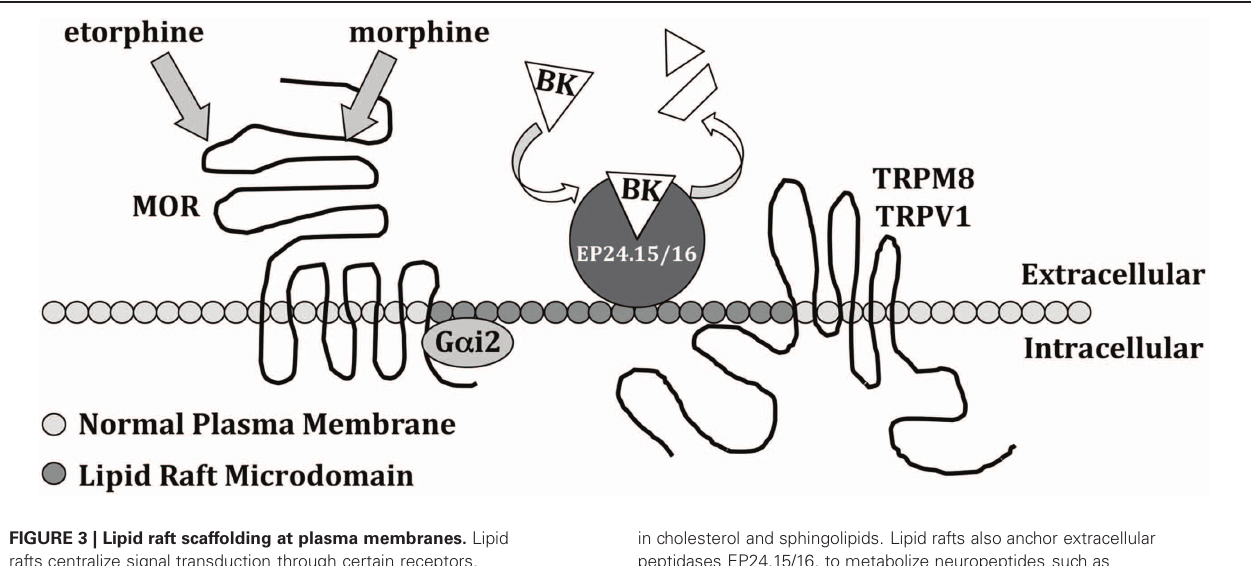
FIGURE 3 | Lipid raft scaffolding at plasma membranes. Lipid rafts centralize signal transduction through certain receptors, including the μ -opioid receptor (MOR), TRPM8 and TRPV1, via their intracellular association with microdomains concentrated